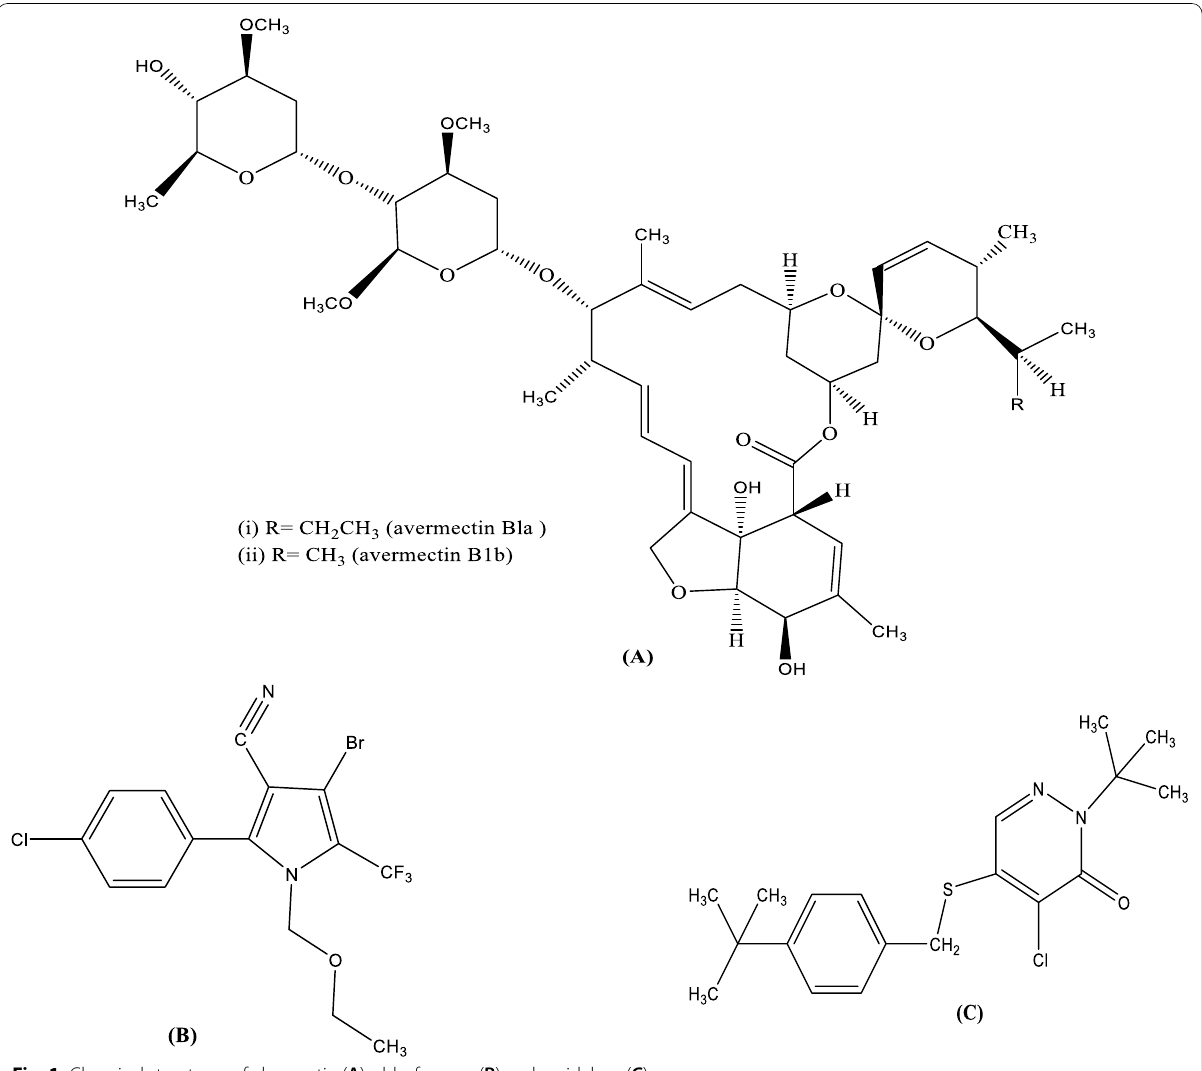
Fig. 1 Chemical structures of abamectin ( A ), chlorfenapyr ( B ) and pyridaben ( C